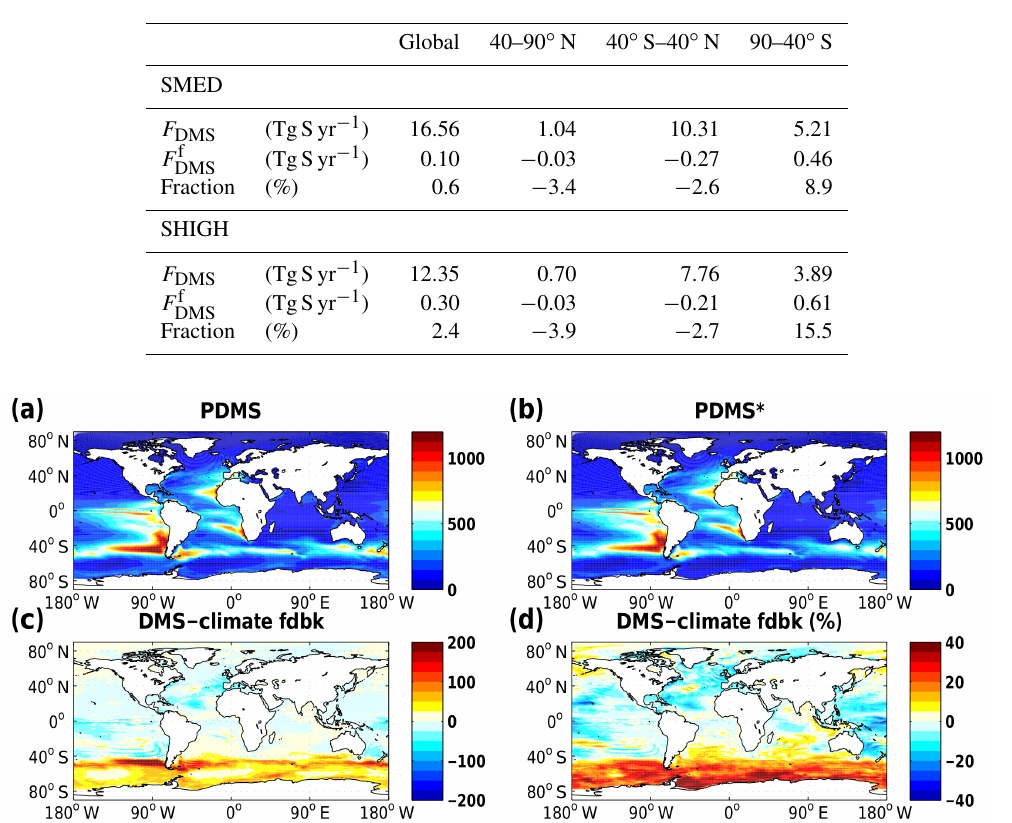
Table 3. Quantification of the DMS–climate feedback on sea–air DMS fluxes in our experiments (averages over the period 2171 to 2200). F DMS denotes DMS fluxes including all feedbacks, while F f Sect. 3.3.3).